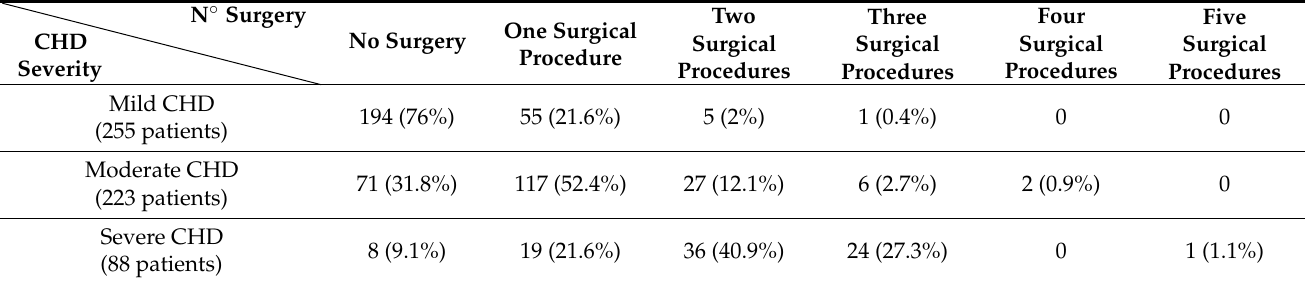
Table 4. Surgical interventions according to CHD severity